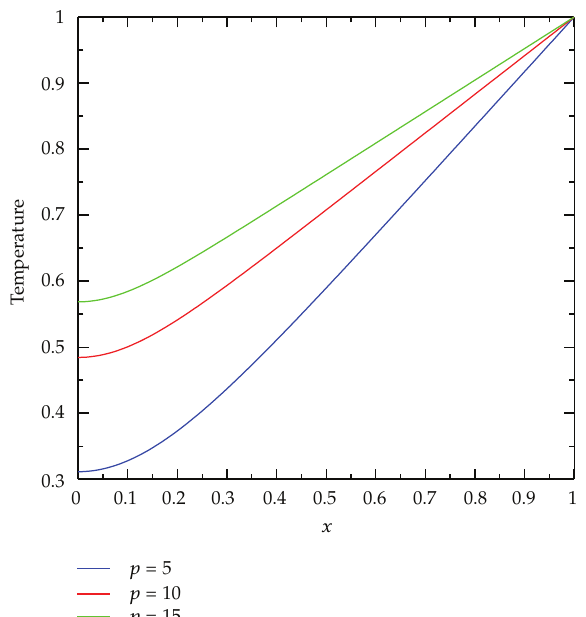
Figure 3: Temperature profile in a fin with varying values of the p . Here the thermogeometric fin parameter is fixed at